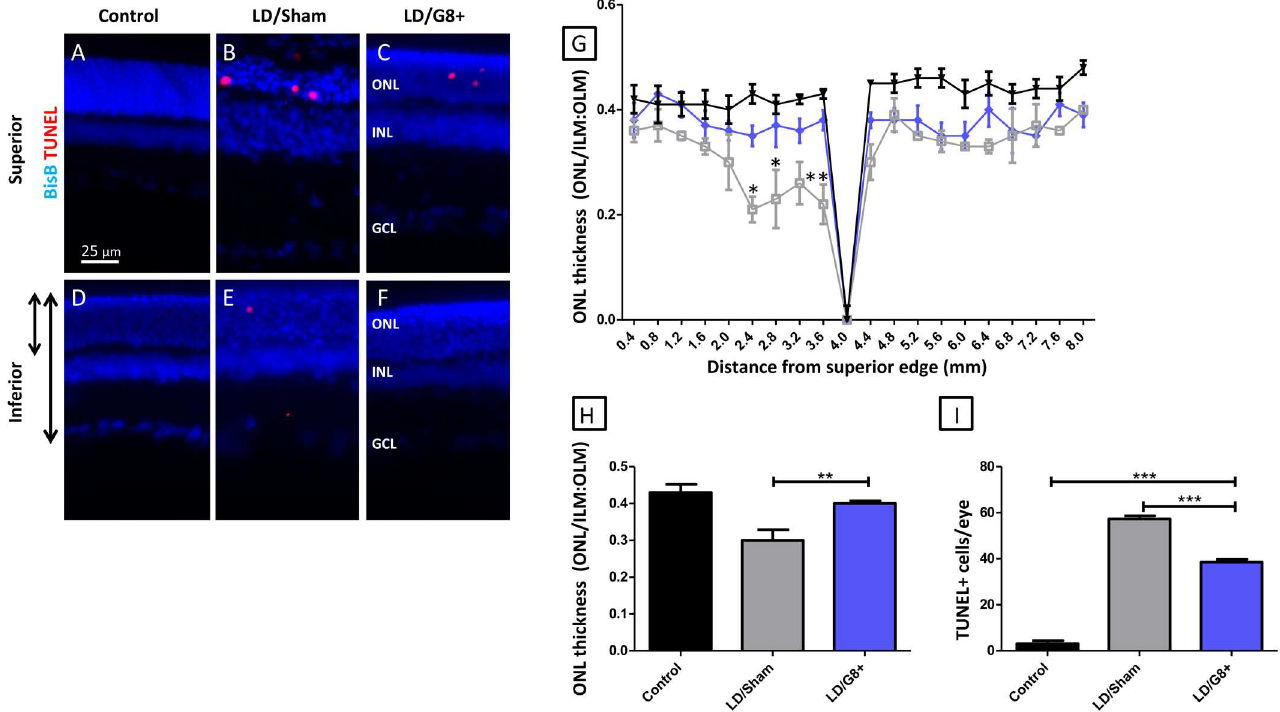
Fig 5. Myo/Nog cell injections mitigated photoreceptor loss. (A-F) Representative sections from superiorand inferior retina of non-light damagedcontrol (control), light damage+ injectionof PBS (LD/Sham) and light damage+ injectionof g8+ cells (LD/G8+). Dying cells were labeled with TUNEL (red) and cell nuclei were stained with bisbenzimide dye (blue). The arrows at the left of D show how the thickness of the ONL (shorter arrow) and of the nuclearlayers of the retina (longer arrow) was measured. Retinas without light damageshowedno labeledcells with TUNEL reagents (A and D). TUNEL+ cells were mostly present in the ONL of retinas with light damagein the superior retina when injectedwith PBS or G8 + cells (B, C and E). TUNEL+ cells were present in the sham injectedeye (E) but not present in these control and G8+ injected sections(D and F). The ONL was disorganizedin the LD/Shamretina, but not in the control and LD/G8+ retinas. (G) NormalizedONL thickness for the non-light damaged) control (black line), LD/Sham (Gray line) and LD/G8+ (blue line) groups from superiorto inferior areas of the retina. Error bars show SEMs. Significantdifference in retinal thickness were seen betweenLD/Sham and LD/G8+; * p < 0.05; ** p < 0.01.(H) Normalised ONL thickness for control, LD/Shamand LD/G8+ groups. Error bars show SEMs. The ONL is significantly thicker in LD retinas treated with G8+ cells than those injected with PBS. No difference was seen in ONL thickness betweencontrol and LD/G8+ sections. ** p < 0.01.(I) Number of TUNEL+ cells in the ONL/section for the same three groups. Error bars show SEMs. Significantly more TUNEL+ cells were present in the LD retinas than control retina (asterisk p value). Fewer TUNEL+ cells were present in the retinas injected with G8+ cells than those injectedwith PBS (asterisk p value). (G-I: Control = 5, LD/Sham= 4, LD/G8+ = 5). *** p < 0.001; ** p < 0.01. ILM, inner limiting membrane; INL, inner nuclear layer; ONL, outer nuclearlayer; OLM, outer